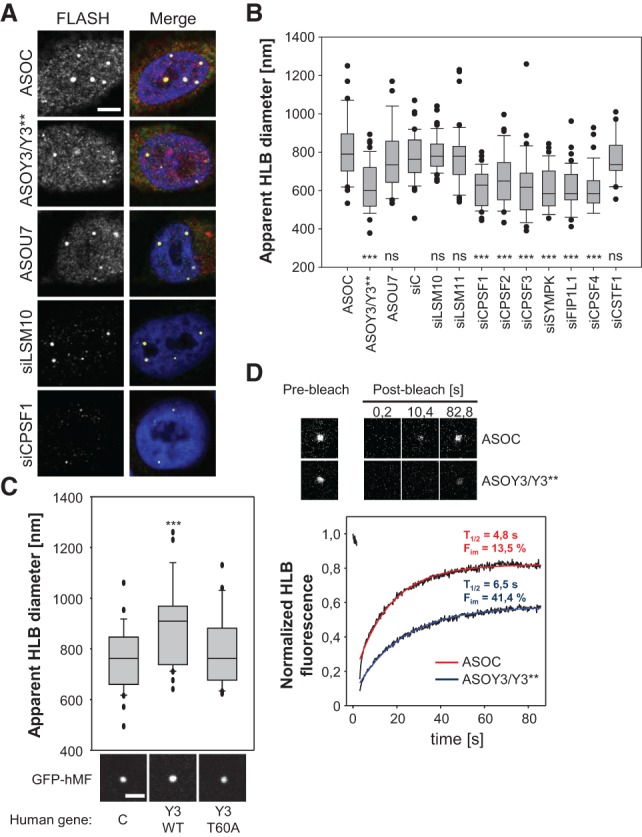
Y3** and the CPSF modulate HLB morphology and protein dynamics. (A,B) The morphology of HLBs was analyzed in human MV3 cells transfected with the indicated ASOs or siRNAs for 48 h by coimmunostaining of Flash and NPAT (see Supplemental Fig. S5A). (A) Representative Flash immunostaining and merged images (DAPI, Flash, and NPAT) are shown. Bar, 5 µm. (B) The apparent diameters of HLBs as determined by Flash staining and laser scanning microscopy is depicted by box plots for the indicated knockdowns. n > 35. (C) HLB morphology was analyzed in CHO-K1 cotransfected with GFP-hMF and empty vector (C) or vectors encoding human wild-type (Y3-WT) or T60A mutated (Y3-T60A) Y3 RNAs. (Top panel) The apparent HLB diameter was determined as in B. n > 35. Statistical significance was determined by Student's t-test, (***) P < 0.001. Representative images of GFP-hMF-positive HLBs are shown in the bottom panel. Bar, 3 µm. (D) HLB dynamics of GFP-hMF were analyzed by FRAP in HEK293 cells transfected with the indicated ASOs for 48 h. Representative images of HLBs before (prebleach) and at the indicated time points after photobleaching (post-bleach) are shown in the top panel. Averaged fluorescence recovery, including analyses of at least 17 HLBs per condition, were fitted and plotted in the bottom panel. Calculated half-time (T1/2) and immobile fraction (Fim) are indicated.